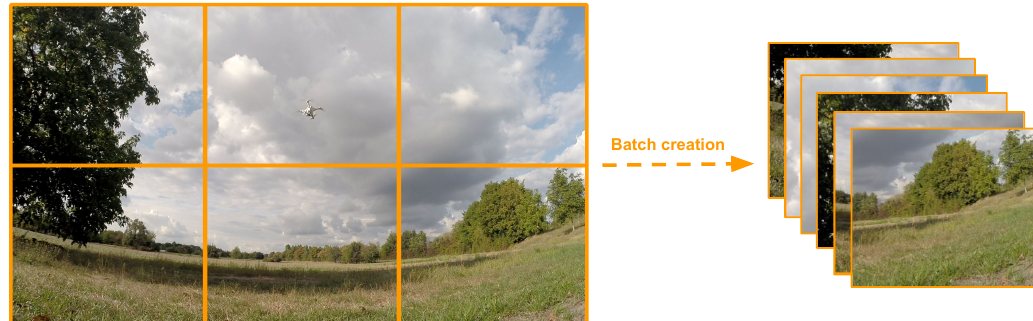
Figure 19. Image tiling strategy used at test time. The image is divided into multiple tiles of a certain size. These tiles are then concatenated to form a batch, which is given in input to the detection network. Predictions from each tiles are aggregated by adding offsets corresponding to their location in the original image. In their implementation, overlaps between tiles are added for better robustness.